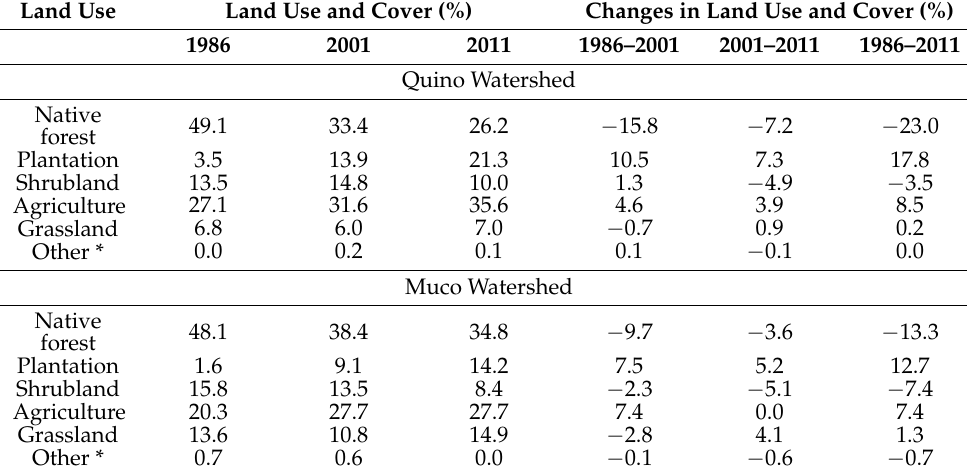
Table A2. Changes in land use and cover types for the observed study years. Land Use Land Use and Cover